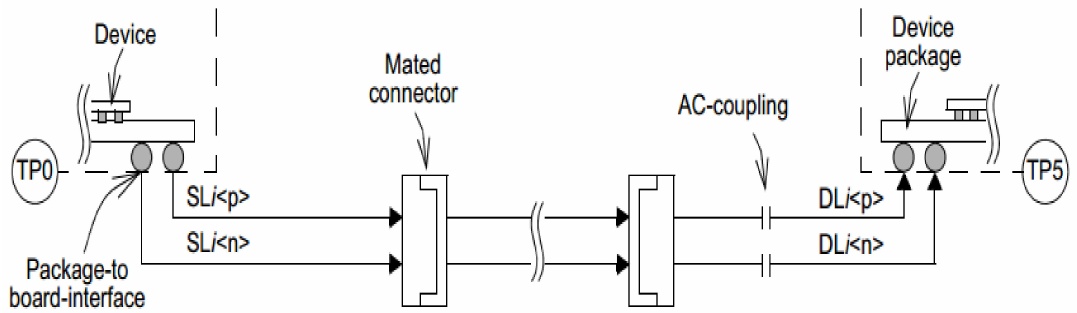
Figure 8. Schematic diagram of 100GBASE-KR4 single channel